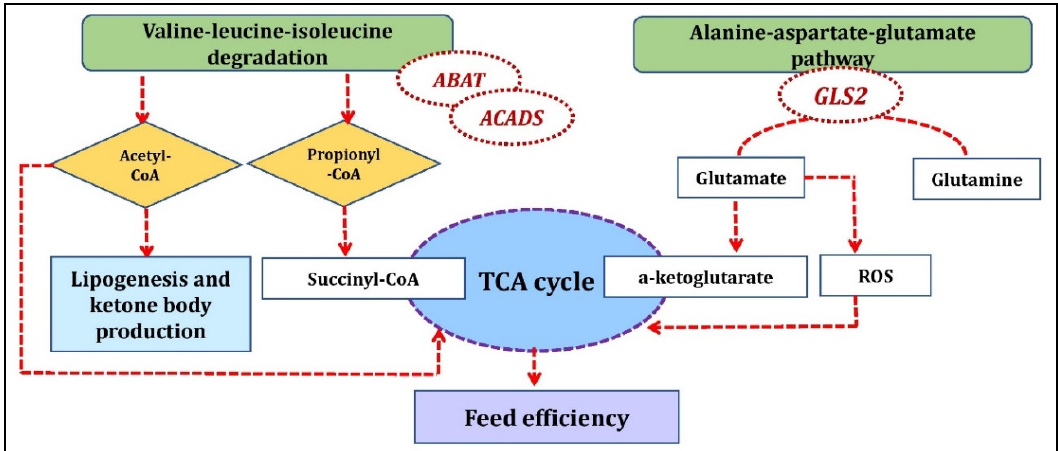
Figure 5. Biological mechanism showing the involvement of genes identified from Duroc anti- correlated/Landrace correlated clusters underlying feed